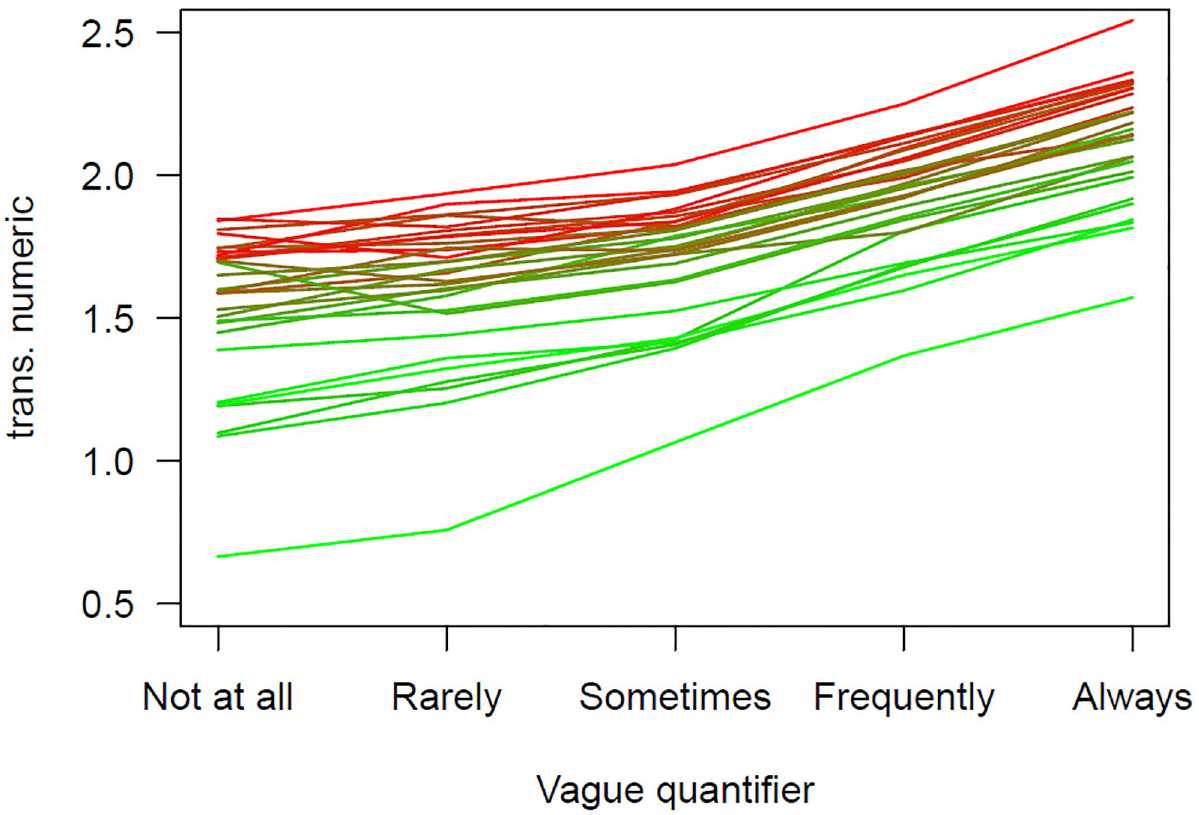
Fig 3. The relationship between the means of the transformed numeric estimates for each vague quantifier by country for the vague quantifier hand sanitizer question. Countries with low free recall responses from the 25% of the sample are shown in green and those with high values in red , with intermediary countries shown in a mixture of these two